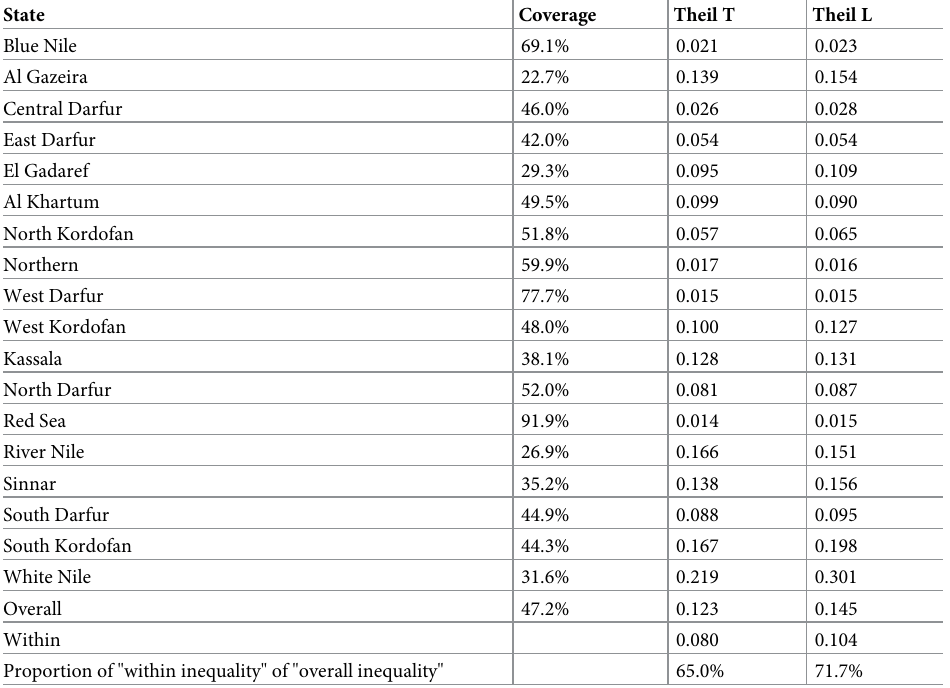
Table 3. Coverage of improved latrines at the school